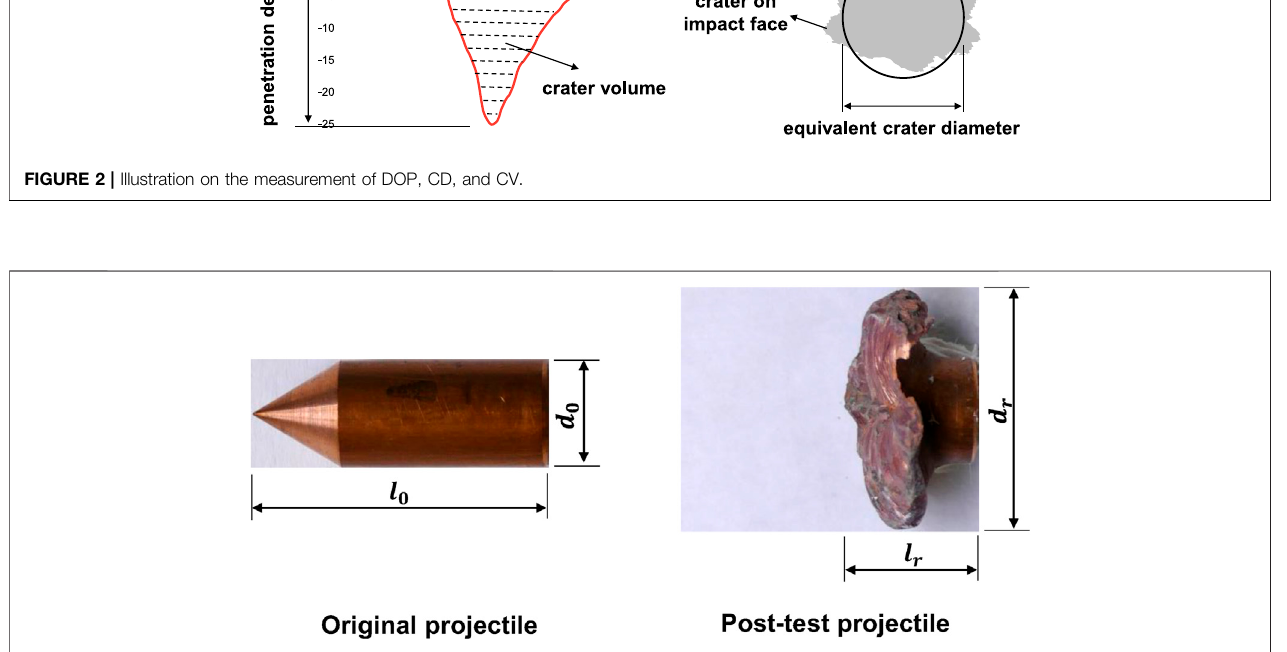
FIGURE 3 | Original and residual length and diameter measurement of a copper